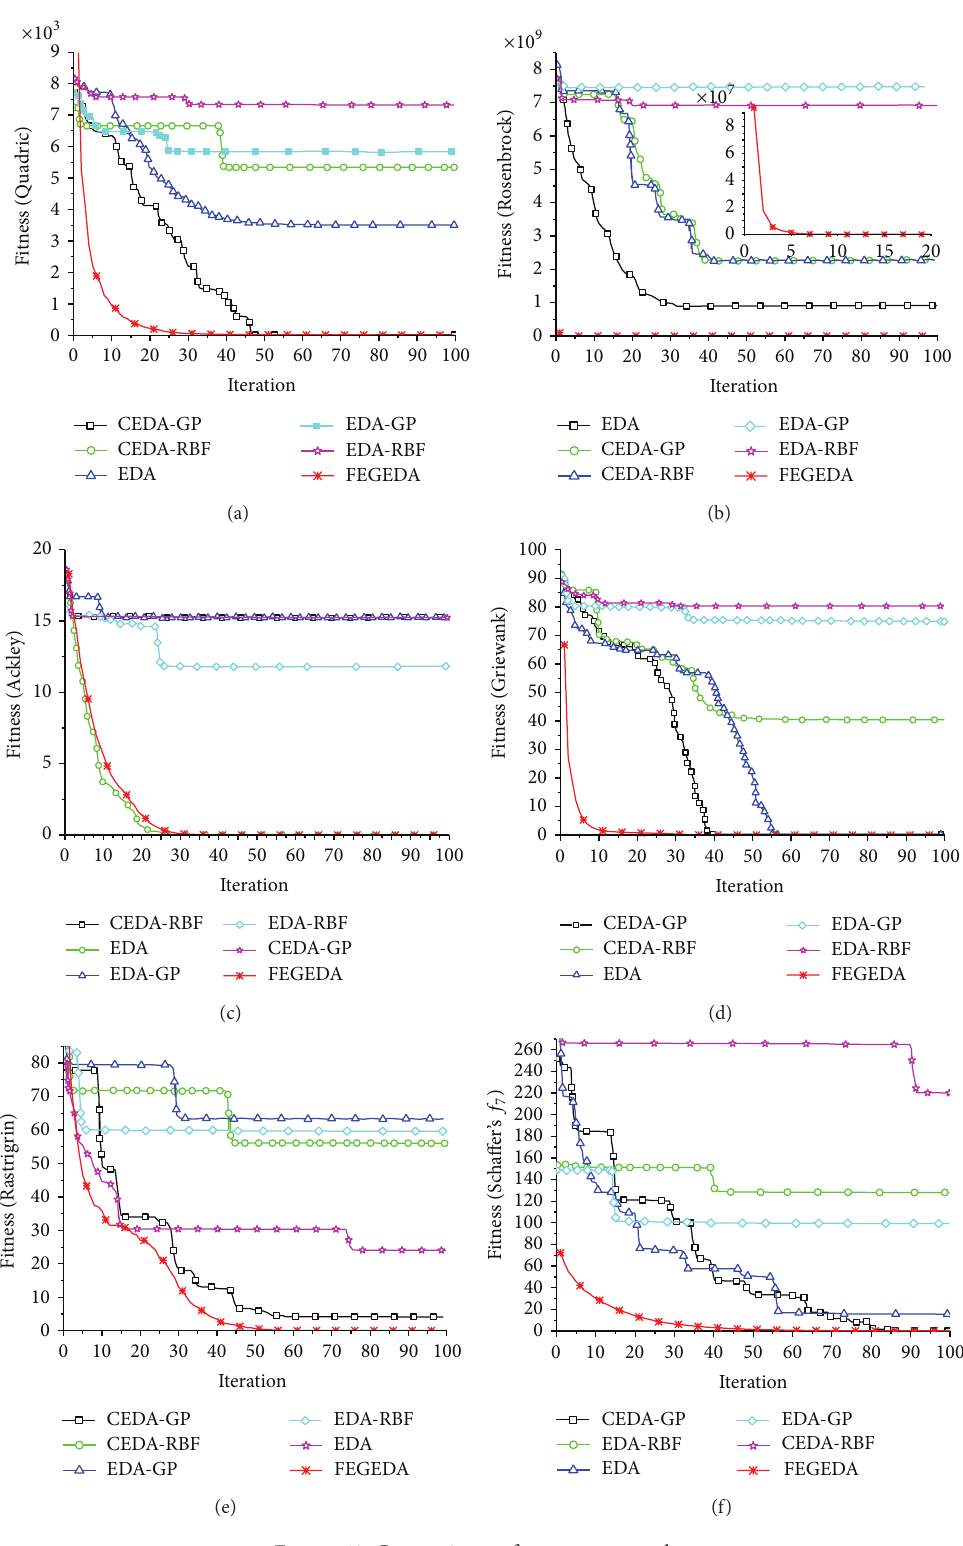
Figure 10: Comparisons of convergent